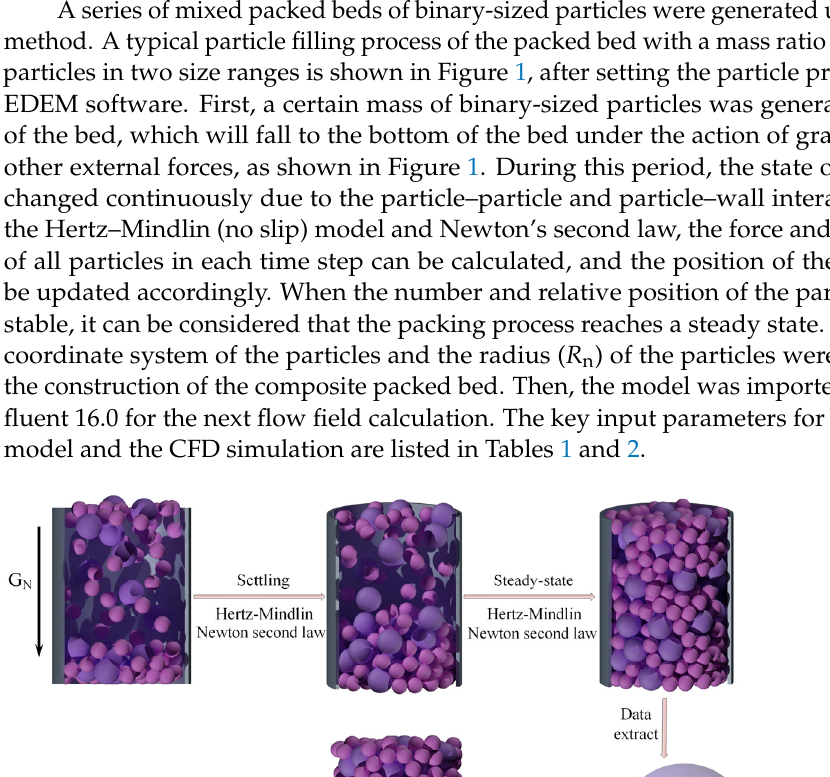
Table 2. Parameters for CFD simulation.